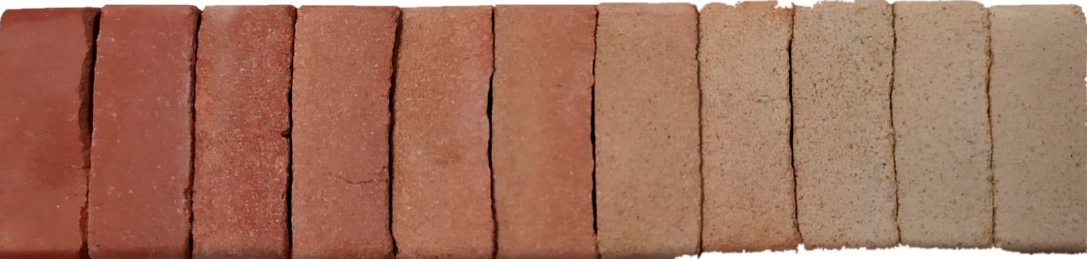
Figure 3. The color of the different families of samples composed of clay and biomass bottom ashes. 100% clay (0A10C) on the left; 100% biomass bottom ash (10A0C)